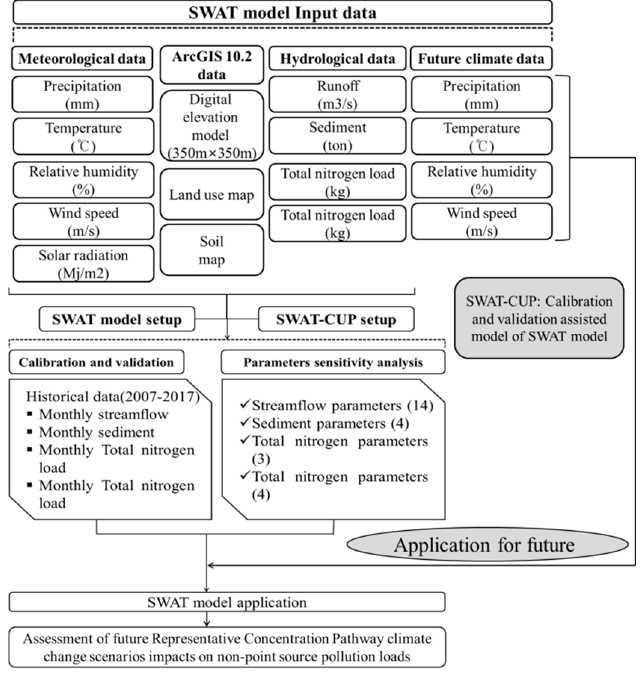
Figure 4. Diagram of the study process.